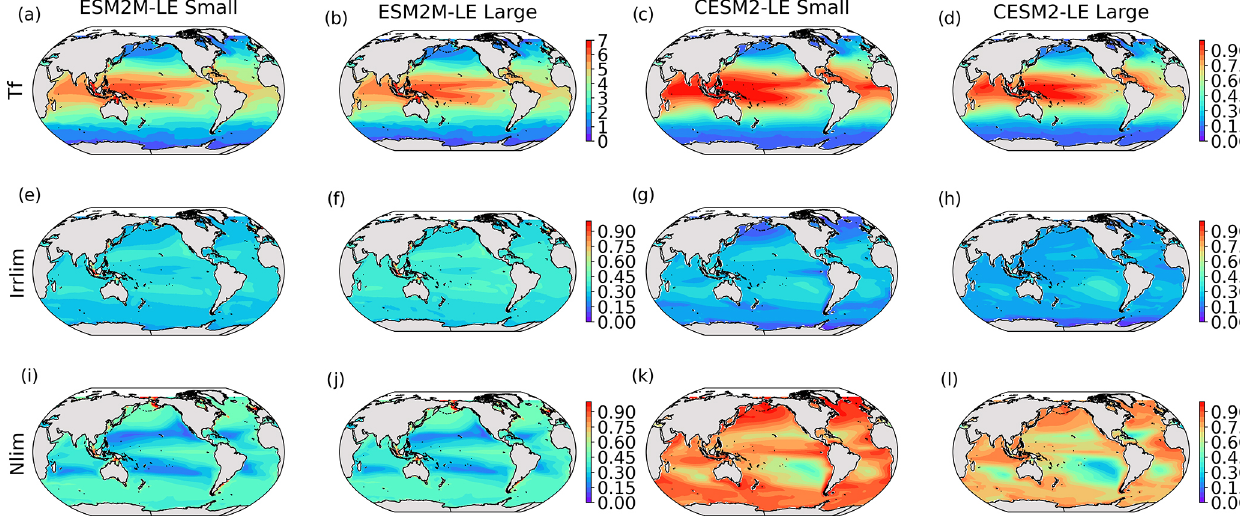
Figure B4. Simulated mean states of the temperature ( a–d , T f ), light ( e–h , Irr lim ), and nutrient ( i–l , N lim ) limitations on the small- and